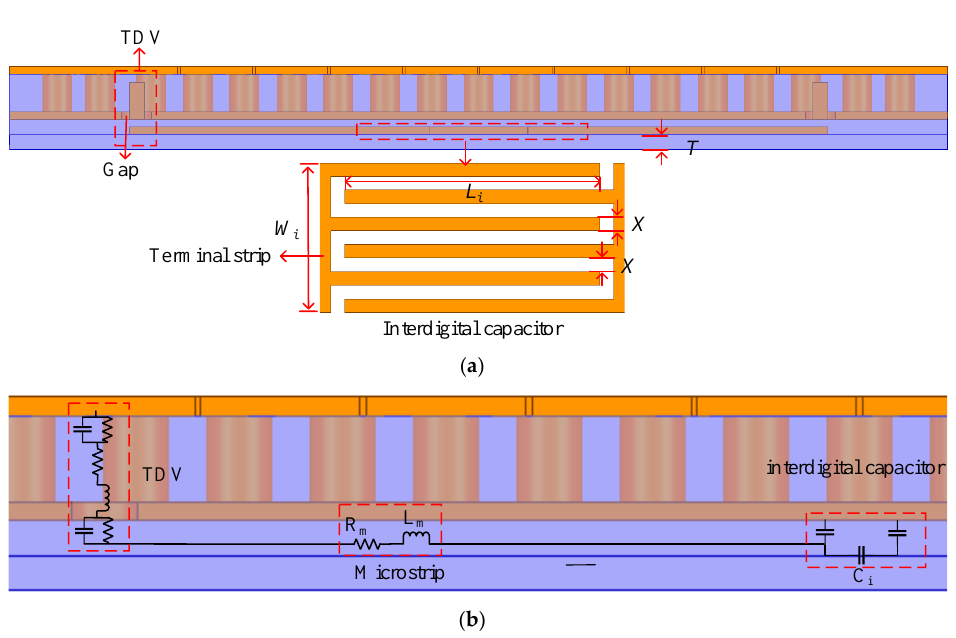
Figure 7. ( a ) Cross-section schematic view of the filter; ( b ) Equivalent lump model of this proposed coupling circuit ( left ).